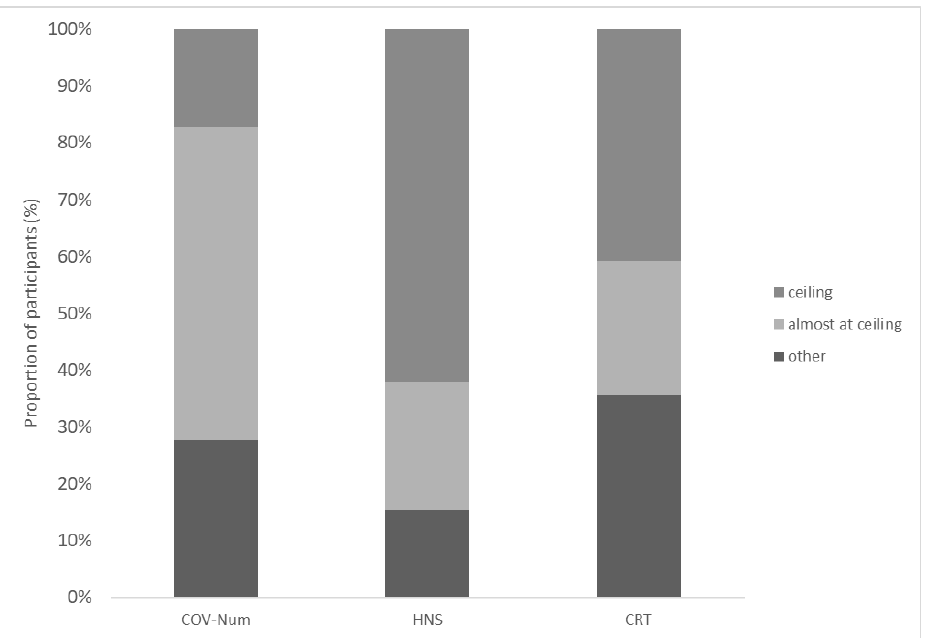
Figure 1. Proportion of the participants performing at ceiling, almost at ceiling, or other on objective scales. Legend: COV-Num = COV Numeracy Scale (ceiling: 4/4 correct; almost at ceiling: 3/4 correct; other: less than 3 correct); HNS = Health Numeracy Scale (ceiling: 12/12 correct; almost at ceiling: 11/12 correct; other: less than 11 correct); CRT = Cognitive Reflection Test (ceiling: 3/3 correct; almost at ceiling: 2/3 correct; other: less than 2 correct).